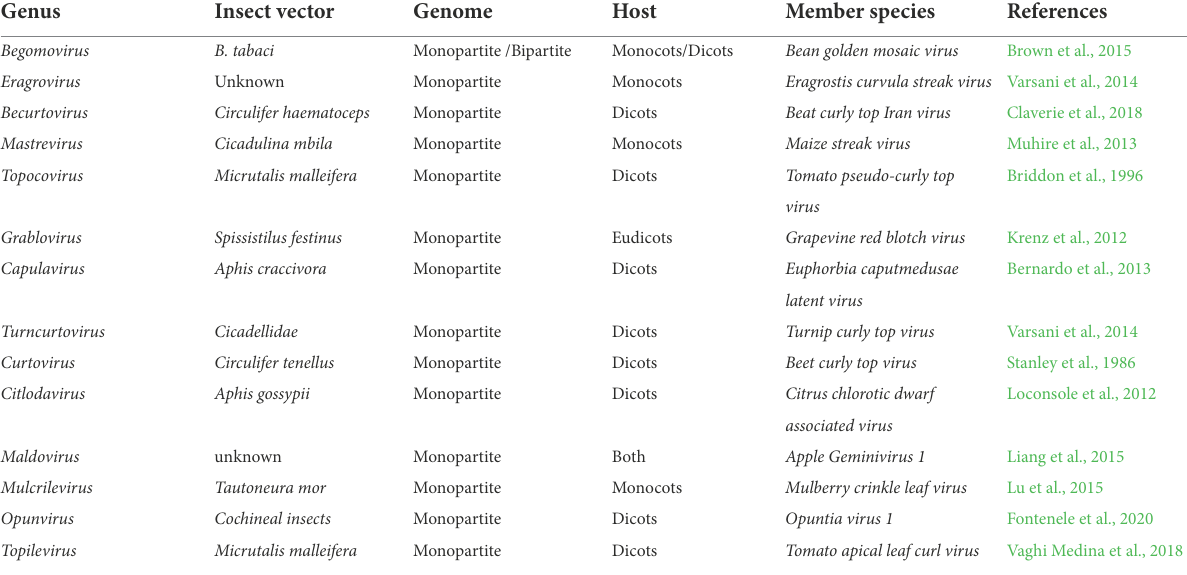
TABLE 1 Currently recognized genera of the Geminiviridae , their properties, and type members by ICTV.